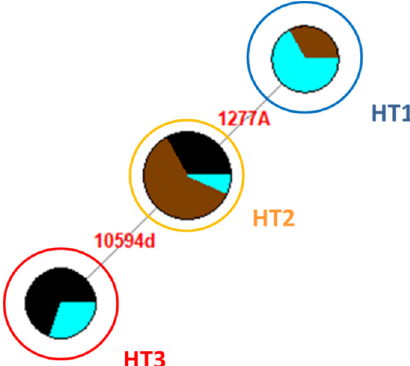
Figure 1. Median-Joining Network based on the non-recombining region of the Y chromosome (NRY) analysis of Sardinian horse breeds. Circles represent three different haplotypes and are proportional to the observed frequency in 34 Sardinian male horses (Table S1). Colors refer to the three Sardinian breeds: Giara (brown), Sarcidano (light blue), and Sardinian Anglo-Arab (black).